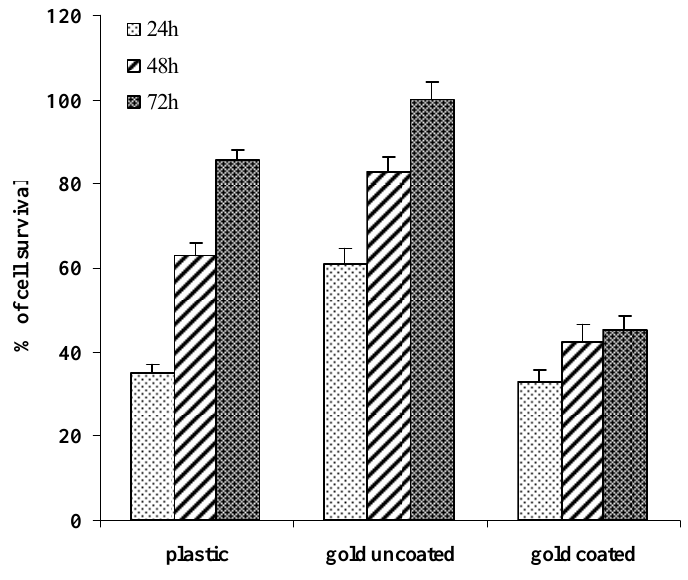
Figure 5. Effect of compound 2 on oriented gold surfaces. Cell viability was assessed at 24, 48, and 72 h of